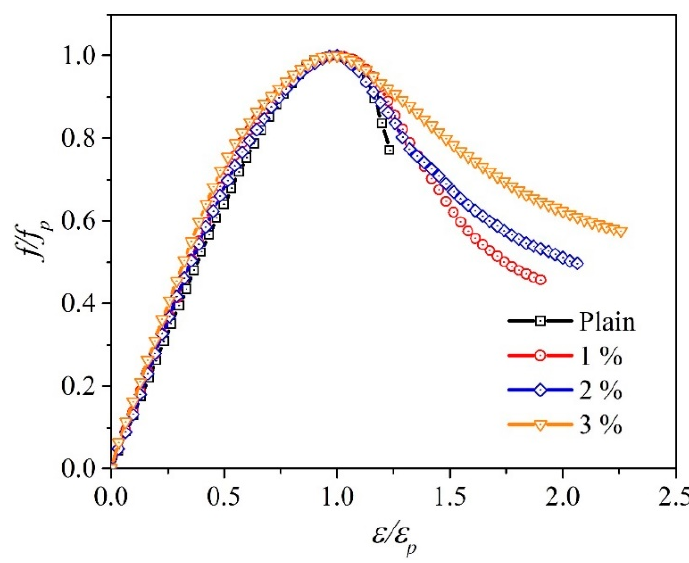
Figure 13. Peak-stress ratio–peak-strain ratio curves. Table 9. Ductility number results.